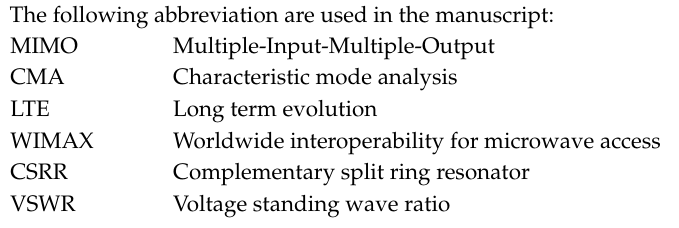
Figure 21. Maximum gain over frequency.